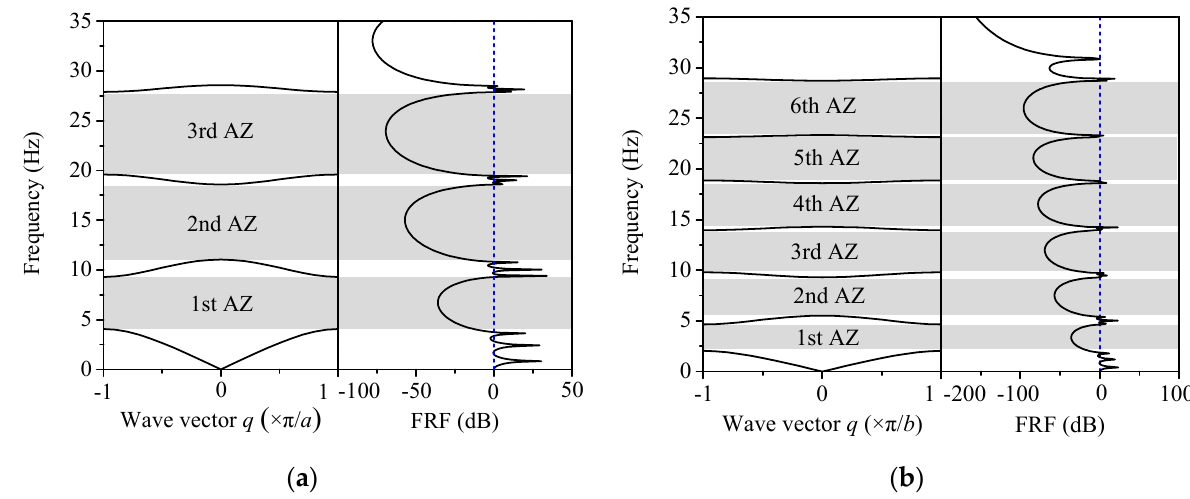
Figure 4. AZs and FRFs of traditional layered periodic foundations with ( a ) Ι –type and ( b ) ΙΙ –type unit cells.